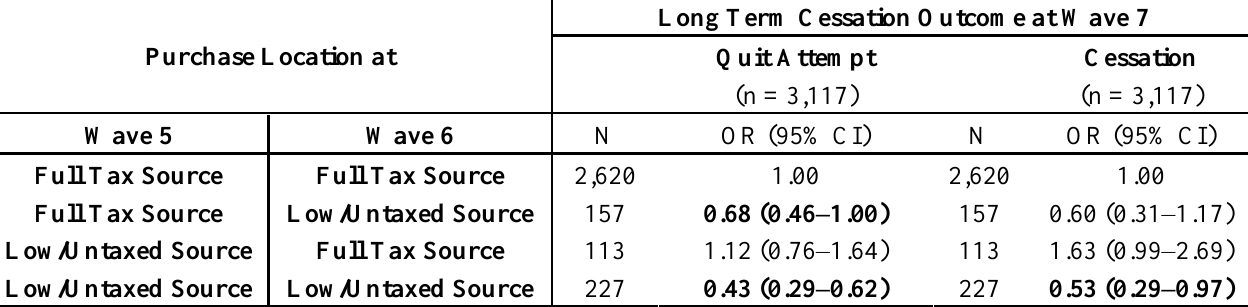
Table 4. Changing location of last purchase between waves 5 and 6 as predictors of Long Term Cessation Outcomes at Wave 7